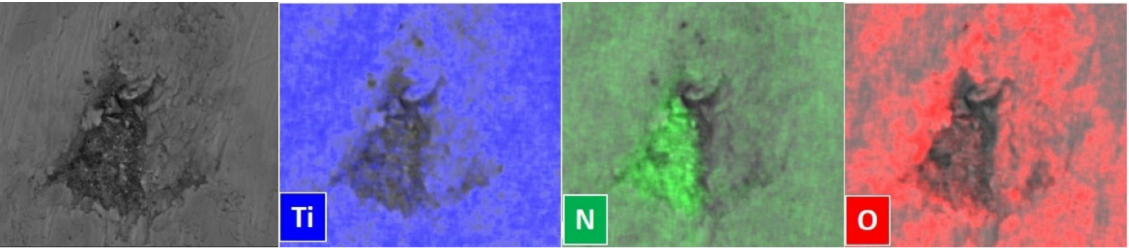
Figure 7. SEM micrograph and EDS maps of EPD TiN-03 sample obtained after EPD deposition of TiN nano/micro powders on a porous Ti